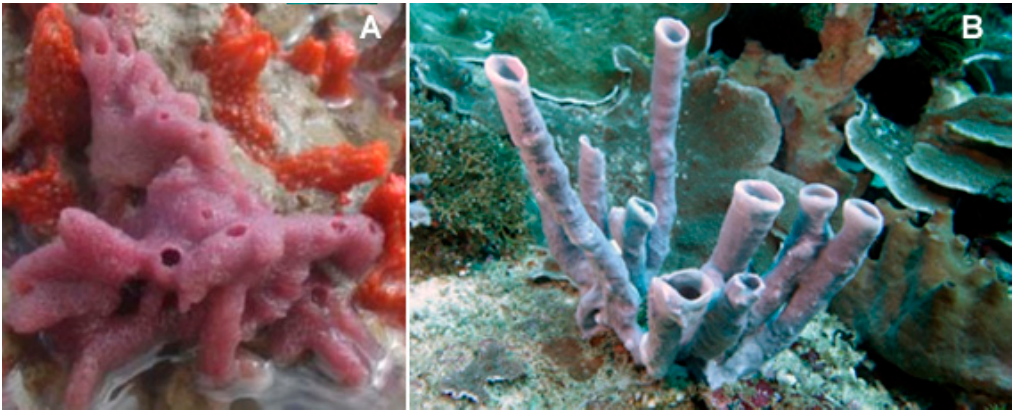
Figure 14. Two examples of species of the genus Haliclona . ( A ) Haliclona implexiformis (Hechtel, 1965); taken from [75]. ( B ) Haliclona fascigera (Hentschel, 1912); (CC BY-SA 3.0) http://www.marinespecies.org/photogallery.php?album=714&pic=132819.